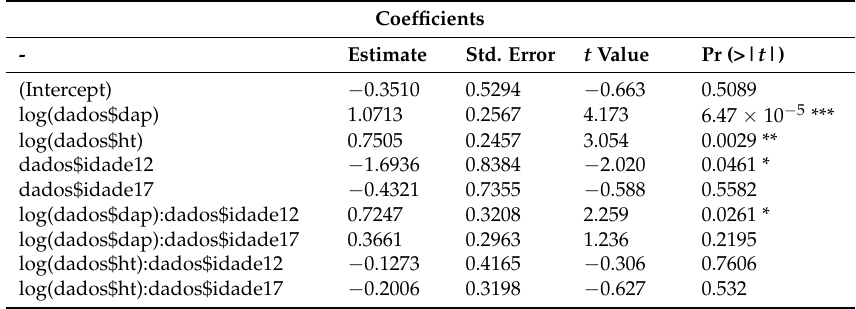
Table A7. R software output table with significance values resulting from ANCOVA for AGDM using C 10 as reference for comparison with C 12 and C